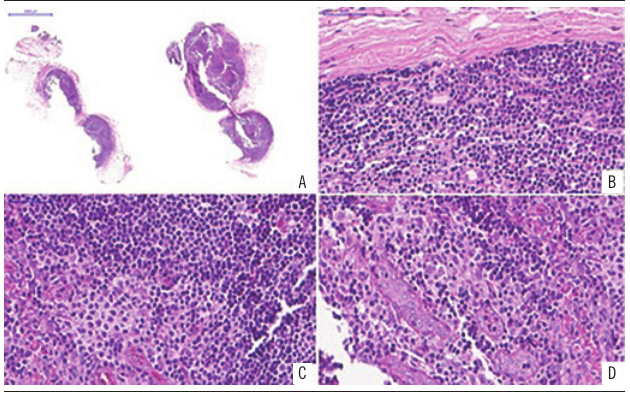
FIGure 2 – Histopathological aspects of FLH (HE) A) microscopic aspect of the surgical specimen showing a well-circumscribed encapsulated lymphoid lesion; B) capsule of dense fibrous connective tissue and lymphocytes with monotonous morphology; C) double population of lymphocytes (small well-differentiated lymphocytes, and collections of reactive lymphoblasts); D) sprouting of small vessels and endothelial cells. FLH: follicular lymphoid hyperplasia; HE: hematoxylin and